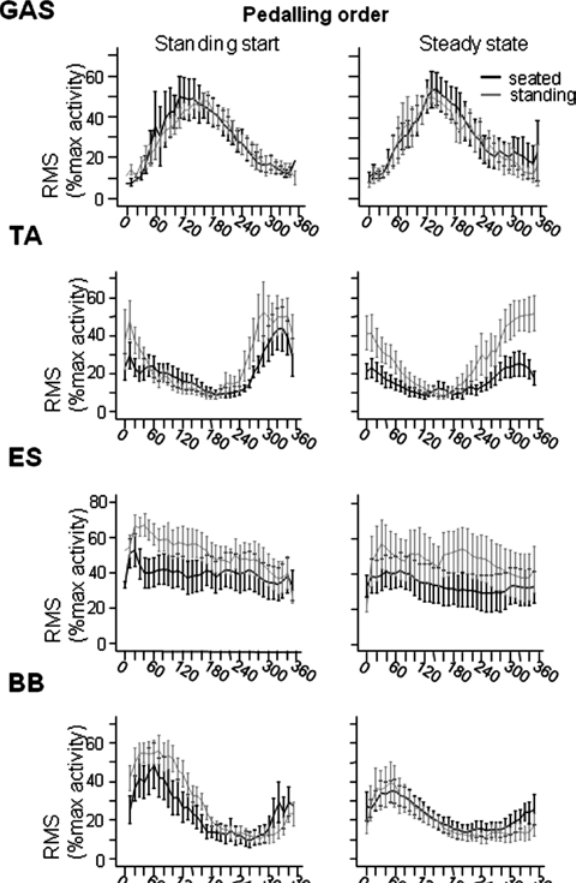
Figure 3. Average sEMG RMSs (% max activity) of the gastrocnemius medialis (GAS), tibialis anterior (TA), erector spinae (ES), and biceps brachii (BB) while pedaling the cycle in seated and standing positions are shown for standing start (left panels) and for following cycling (“Steady state”, right panels). Values are shown as mean ±